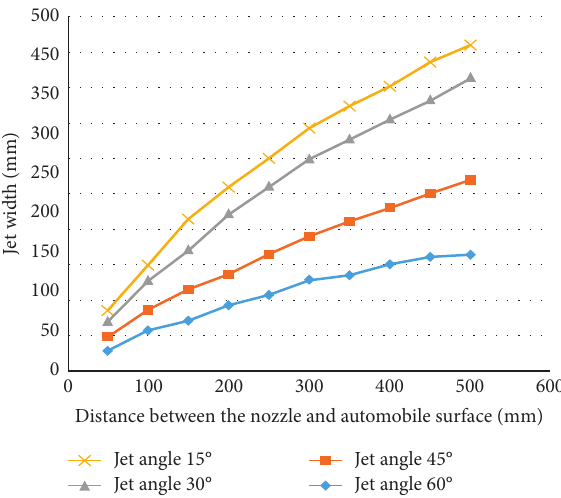
Figure 18: Relationship curve between jet target distance and jet width under different jet